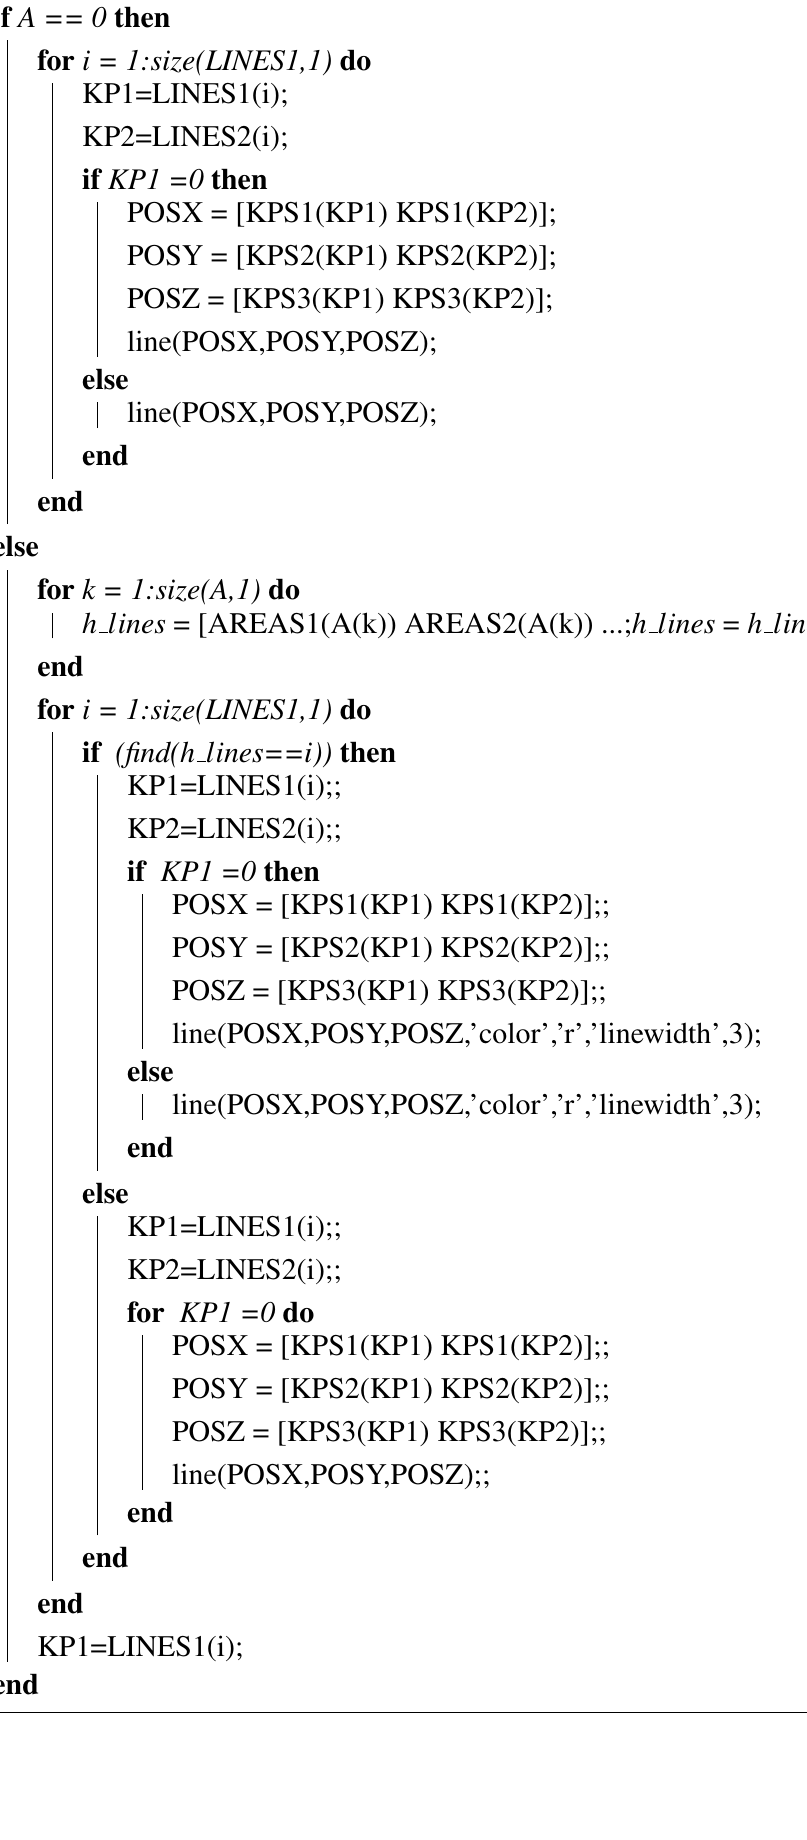
Algorithm 2 : Implementation example of data acquisition algorithm from ANSYS to